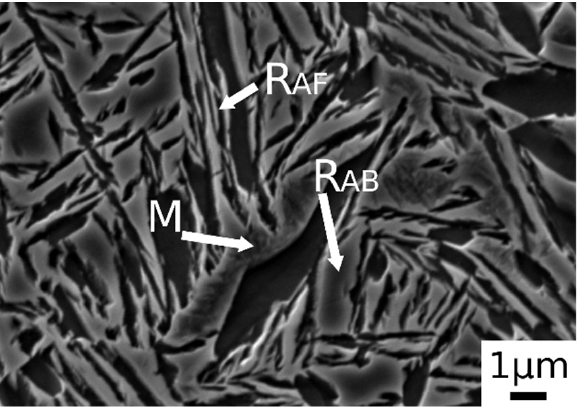
Figure 4. SE - SEM image at high magnification of the alloy after austenitizing at 850 °C (30 min) and austempering at 350 °C for 30 min. (M martensite, R AB blocky retained austenite, R AF filmy retained austenite).